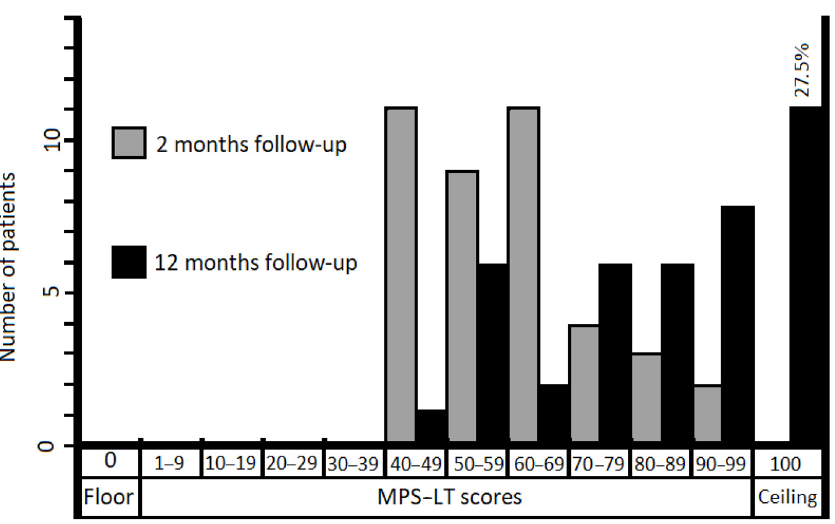
Figure 1. Bar graph showing distribution of MPS-LT scores for patients (n = 40) after pelvic frac- tures.